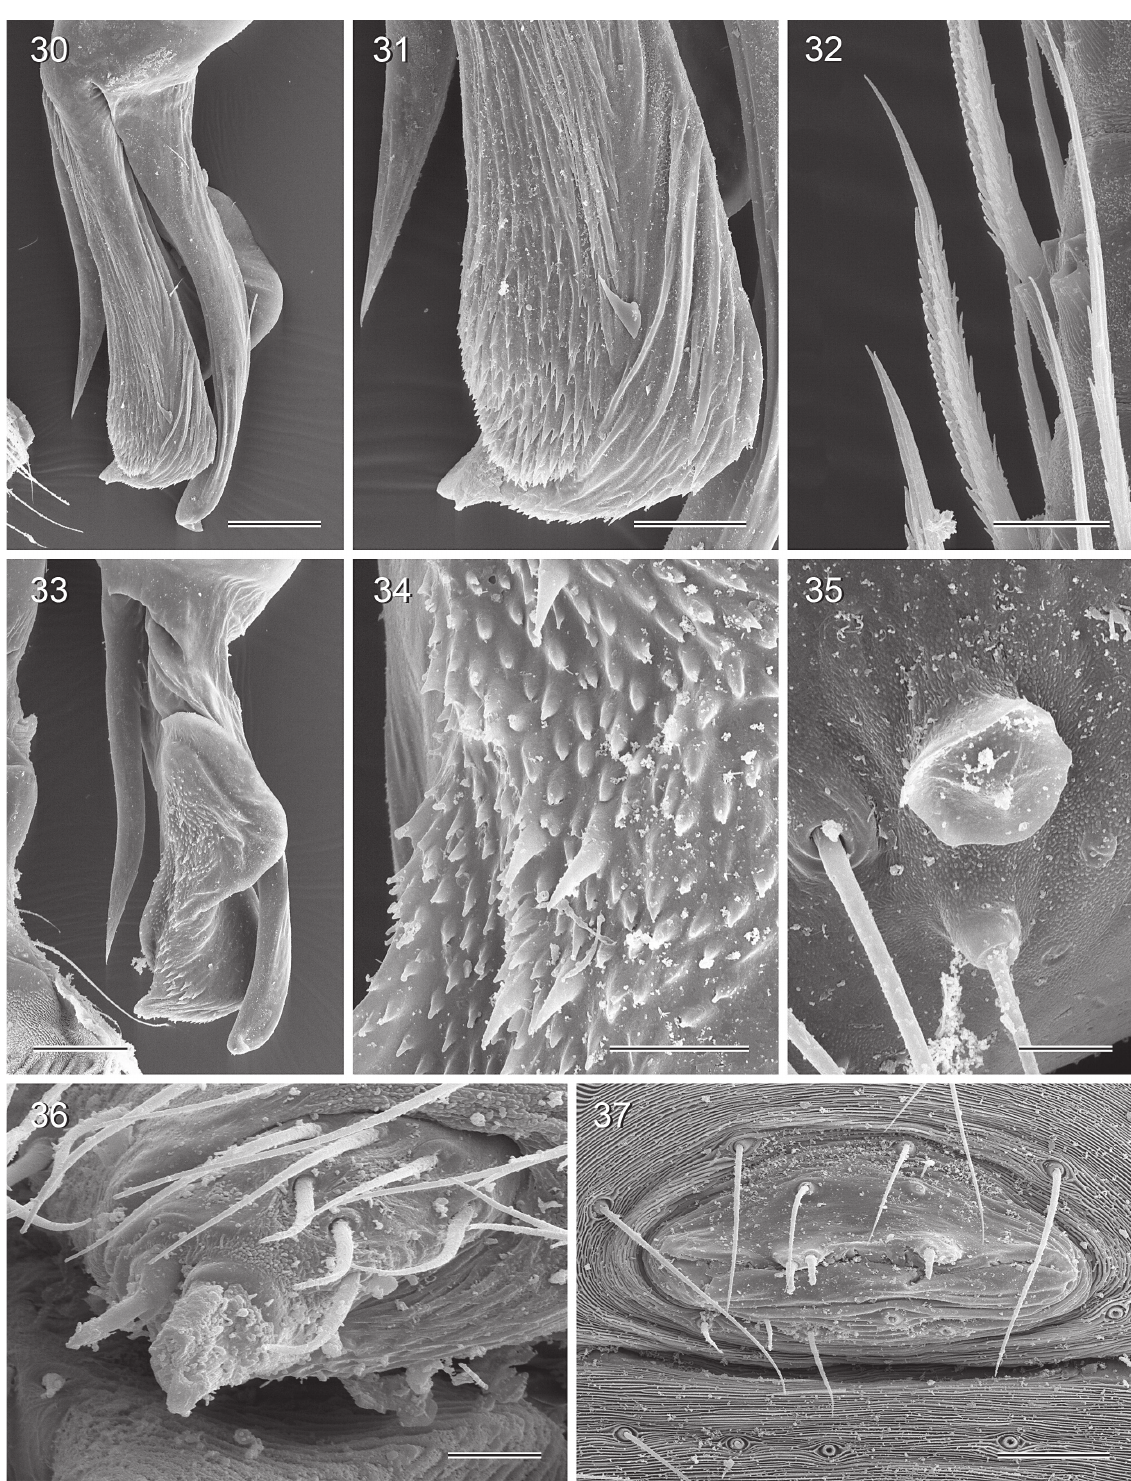
Figs 30–37. Aetana libjo Huber, sp. nov. 30 . Processes of right genital bulb, retrolateral view. 31 . Detail of preceding. 32 . Comb-hairs on female tarsus 4. 33 . Processes of left genital bulb, prolateral view. 34 . Detail of preceding. 35 . Male palpal tarsal organ. 36 . Female ALS. 37 . Male gonopore. Scale lines: 30, 33 = 100 µm; 31, 37 = 40 µm; 32, 34 = 20 µm; 35–36 = 10